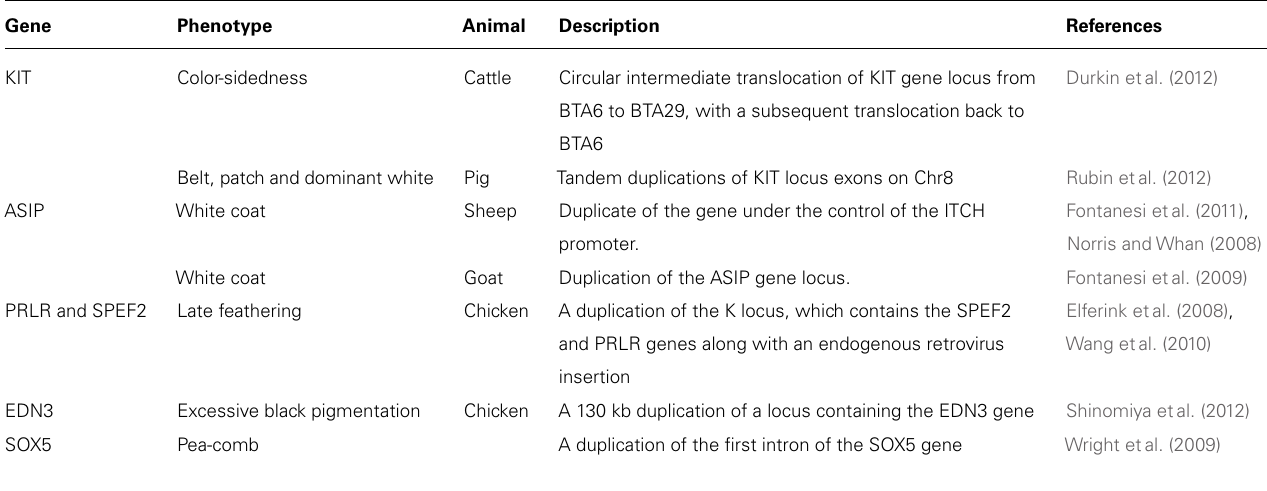
Table 1 | Genes associated with external phenotypes that are influenced by structural variants in